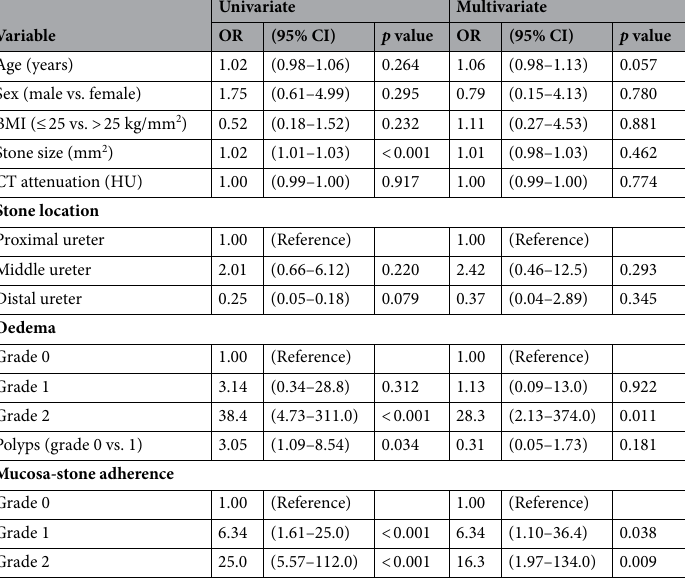
that 98 days until surgery was the optimal cutoff value predictive for MSA, with an area under the curve of 0.78 (95% confidence interval, 0.69–0.88) (Fig. 1a). This cutoff had a sensitivity of 68.4% and a specificity of 79.5%. Younger age (OR 0.96; p = 0.004) and immediate intervention (OR 0.90; p = 0.023) were independent risk factors predicting grade > 2 DUT. ROC curve analysis revealed that 34 days was the cutoff value predictive for DUT,